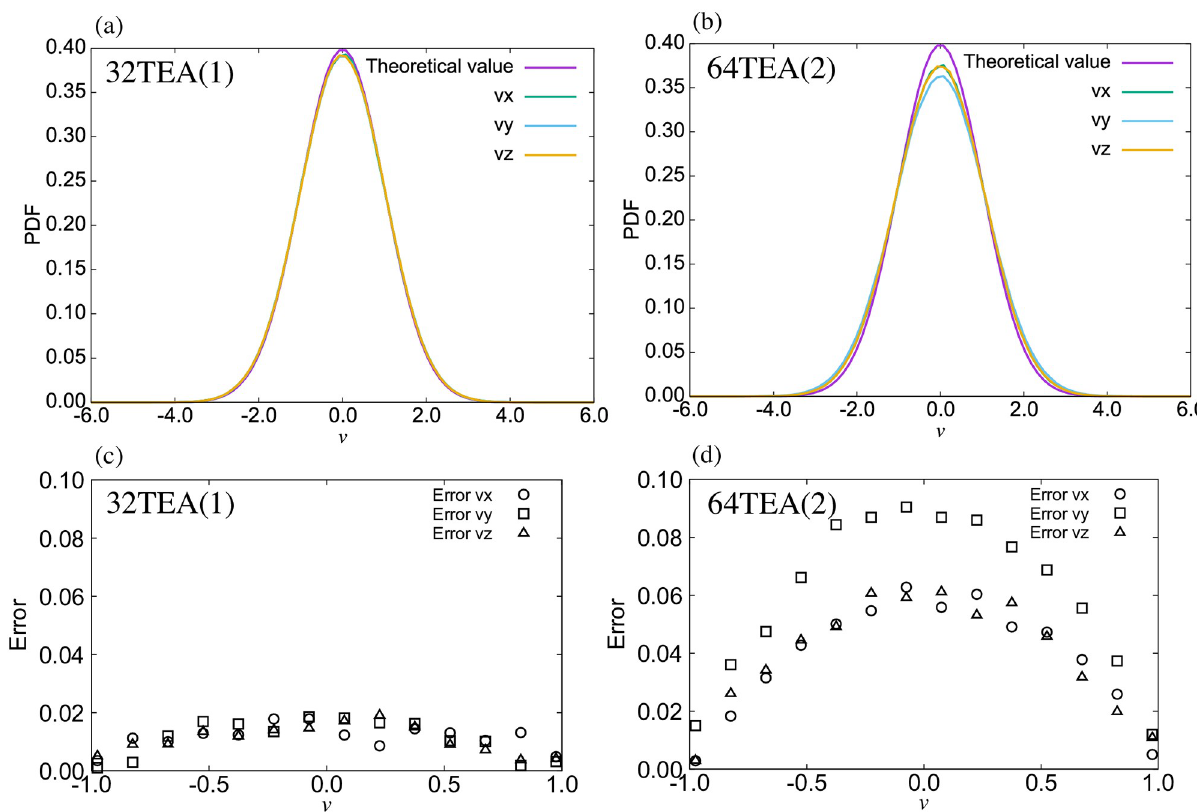
Fig 4. Probability distribution function (PDF) of the velocity for the water system using (a) 32TEA(1) and (b) 64TEA(2) and the error rate of the velocity distributions using (c) 32TEA(1) and (d) 64TEA(2).